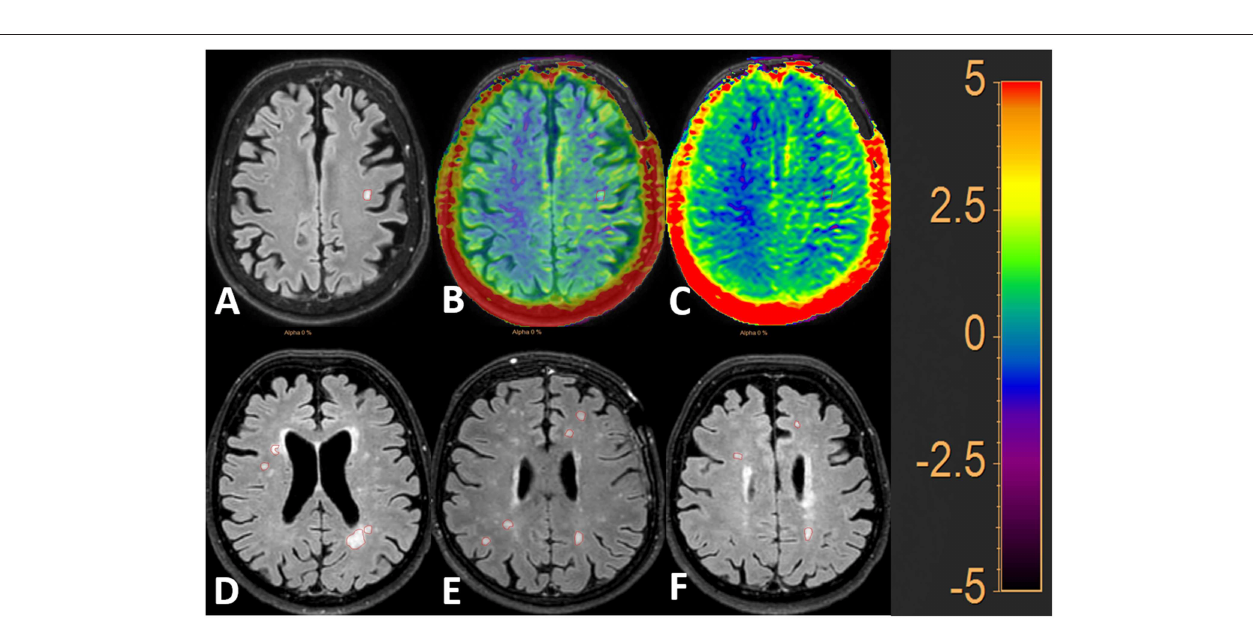
FIGURE 3 | FLAIR image with 50 and 100% APTw image overlay. White matter hyperintensities of presumed vascular origin (WMH) are outlined in red. The image to the left shows the lesions on FLAIR (A) , the middle image shows the FLAIR image with 50% APTw overlay (B) and the image to the right shows the FLAIR image with 100% APTw overlay (C) . Additional examples of the lesion selection are given in (D–F) .